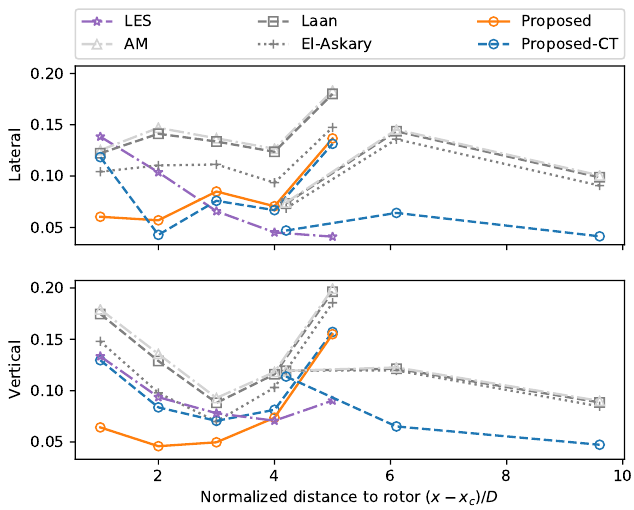
Figure 18. RSME of the wake deficit at hub height under the stable condition: “-CT” represents models using AD based on the thrust